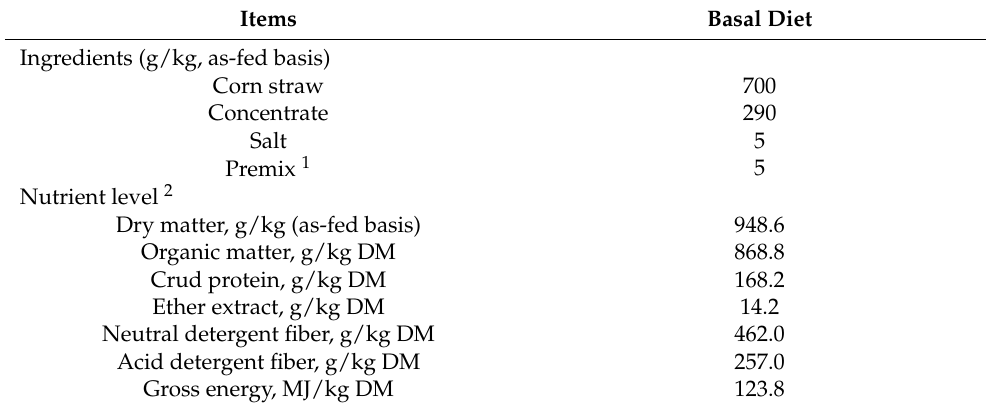
Table 1. Ingredients and nutrient level of the basal diet for Dezhou donkeys. Items Basal Diet Ingredients (g/kg, as-fed basis) Corn straw 700 Concentrate 290 Salt 5 Premix 1 5 Nutrient level 2 Dry matter, g/kg (as-fed basis) 948.6 Organic matter, g/kg DM 868.8 Crud protein, g/kg DM